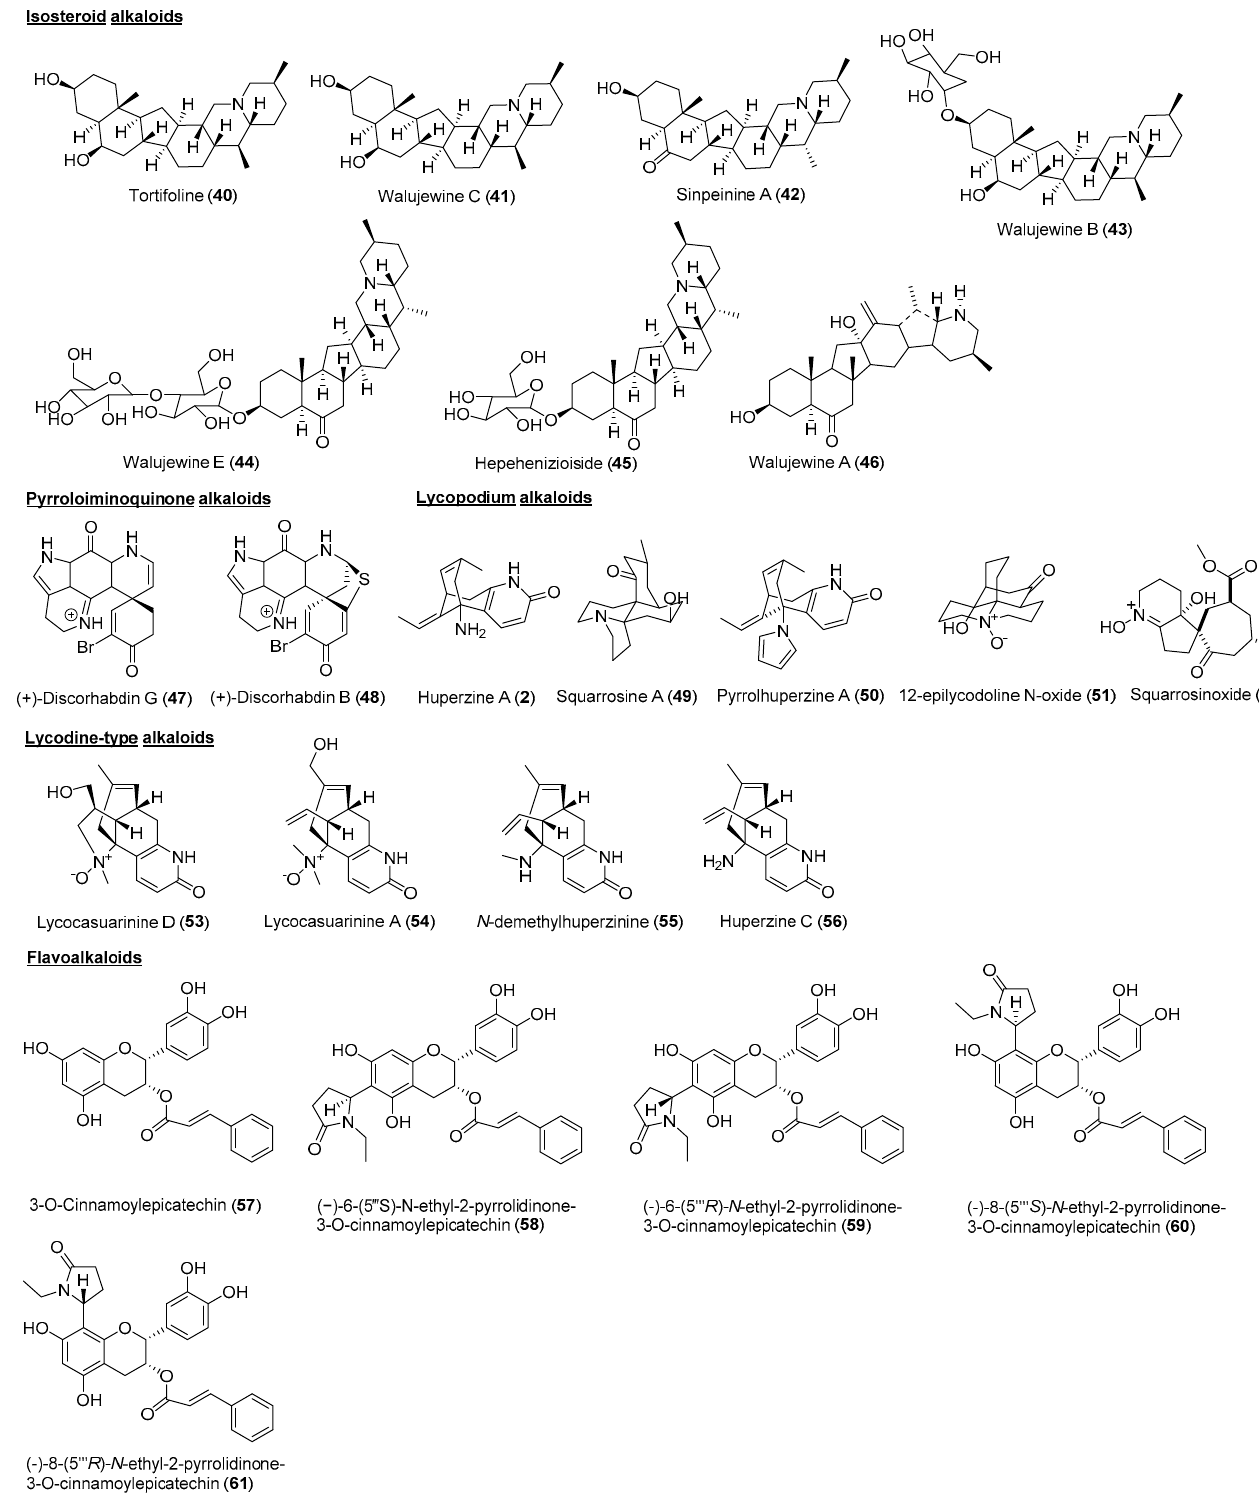
Figure 4. Chemical structures of alkaloid 2 , 40 – 61 . Indole alkaloids are among the largest group of heterogeneous secondary metabo- lites, comprising a six-membered aromatic ring fused to a five-membered nitrogen-con- taining pyrrole ring [36]. Rescinnamine ( 3 ) from Rauvolfia reflexa was reported to behave as a dual cholinesterase inhibitor (IC 50 AChE 11.01 μ M; BuChE 8.06 μ M) [20]. Monoterpene indole alkaloids are recognised as molecules containing a monoterpenoid unit fused to an indole moiety. Monoterpene indole alkaloids ( 4–6 ) isolated from the Nauclea officinalis pos- sess selective BuChE inhibitory activity. Angustidine ( 4 ), nauclefine ( 5 ) and angustine ( 6 )